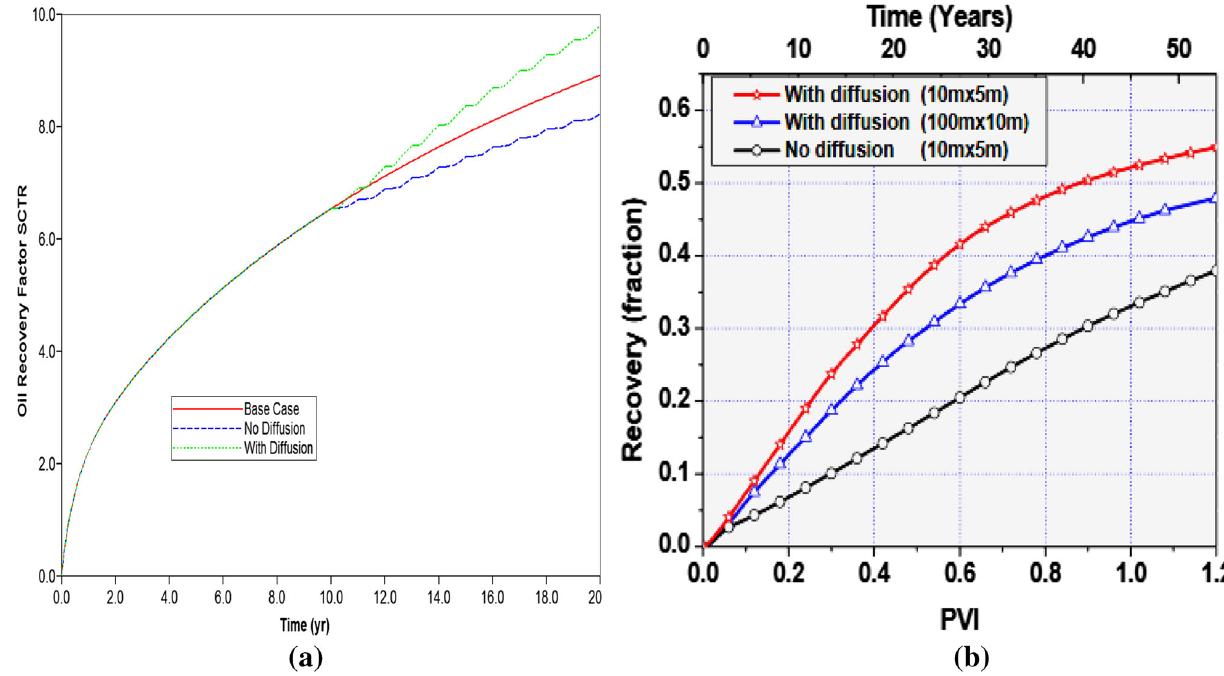
Fig. 11 Effect of molecular diffusion on CO 2 -EOR performance: a CO 2 performance in shale oil reservoirs—Bakken model, b CO 2 performance in fractured conventional reservoirs (Hoteit and Firoozabadi 2009)